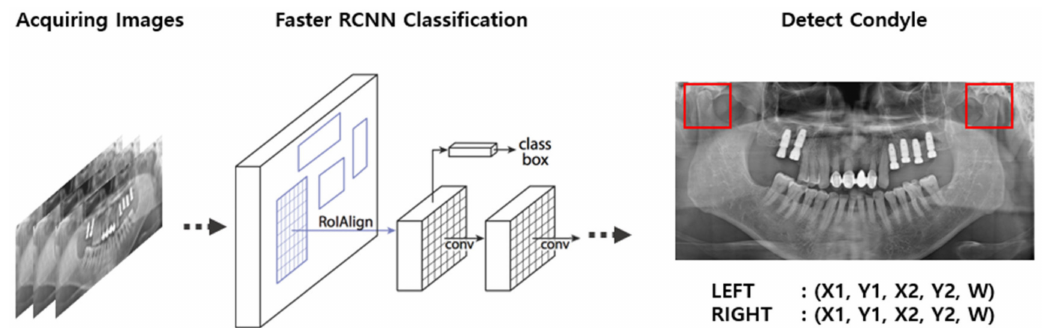
Figure 3. Condyle detection classification